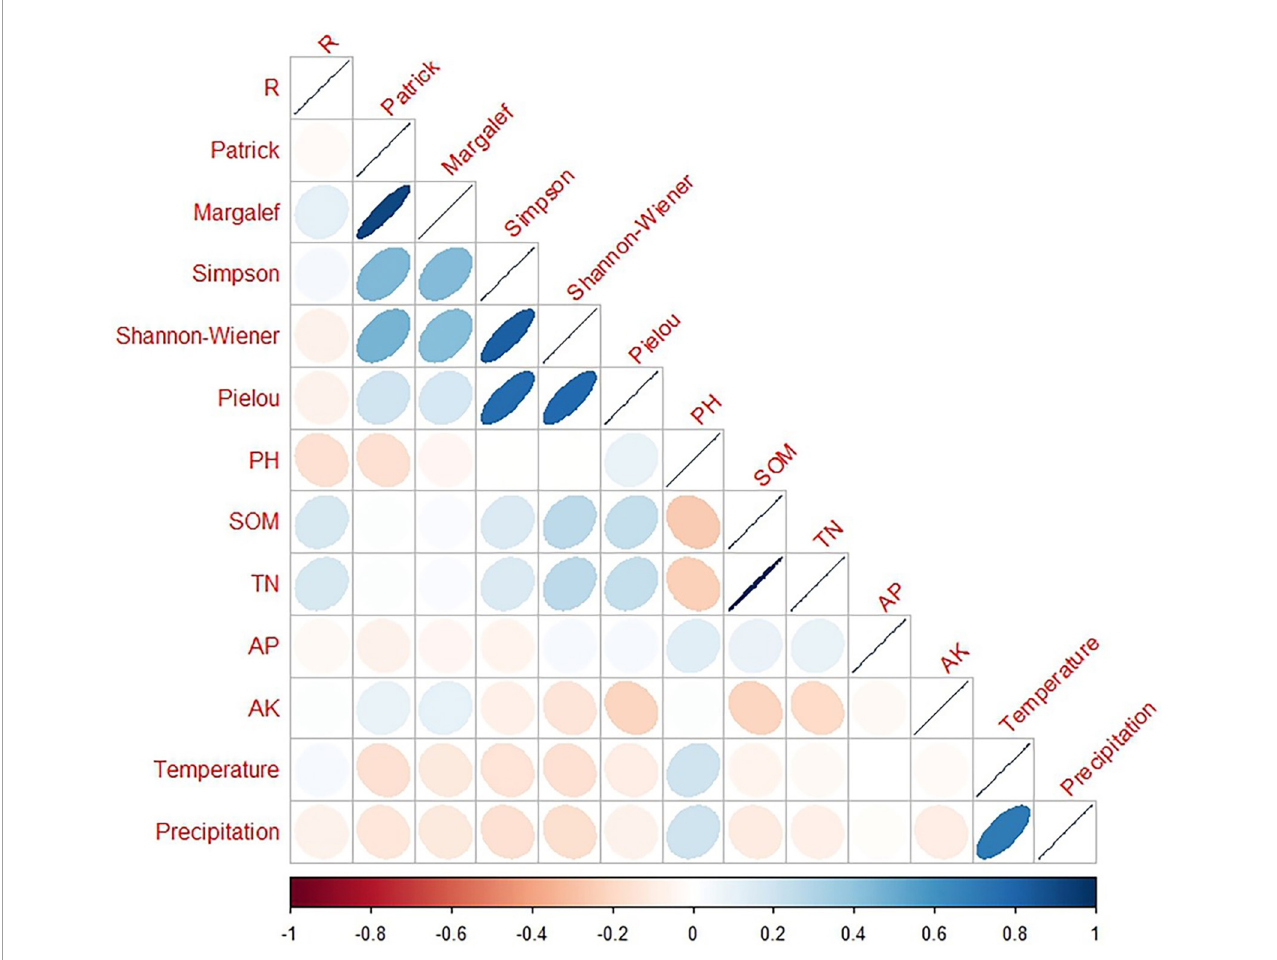
FIGURE9 Correlation matrix between R. pseudoacacia growth rate and different properties in mingled stands. Blue color indicates positive correlation and red color indicates negative correlation. Precipitation (mm); Temperature ( ◦ C); pH; SOM (g/kg); TN (g/kg); AP (mg/kg); AK (mg/kg). The closer the graph is to a straight line (that is, closer to 1 or –1), the stronger the